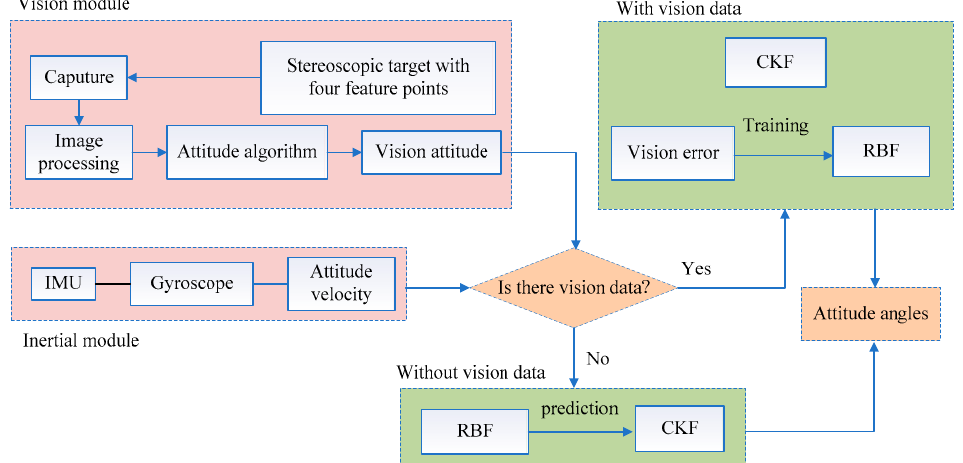
Figure 2. Vision and inertial integrated attitude measurement model. RBF: radial basis function; CKF: cubature Kalman filter.